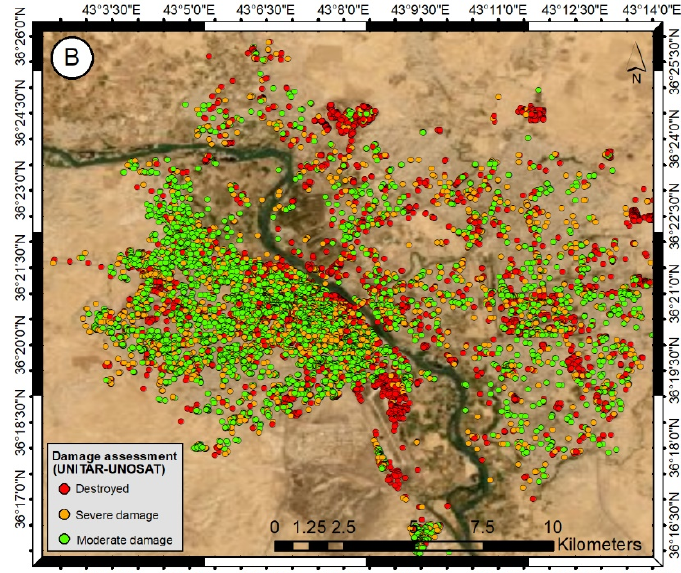
Figure 1. Map of Mosul and estimated damaged buildings. ( A ) shows zonal division and major land uses (data source: UNHabitat, 2019) and ( B ) shows three classes of damage severity in colored dots, courtesy of UNITAR-UNOSAT. The source for the UNITAR-UNOSAT map is available at: http://unosat-maps.web.cern.ch/unosat-maps/IQ/CE20140613IRQ/UNOSAT_A3_Mosul_